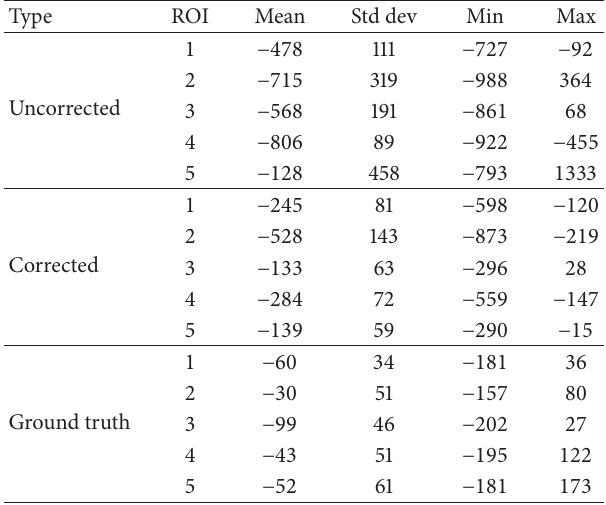
Table 1: Comparison of the measurements of the ROIS shown in Figure